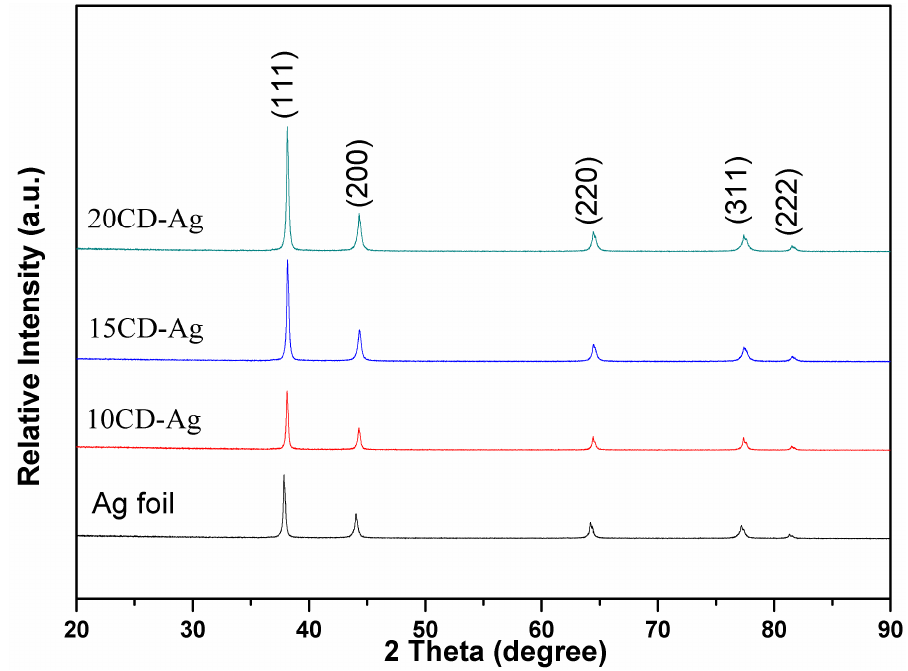
Figure 1. XRD patterns of the prepared CD-Ag materials and Ag foil.